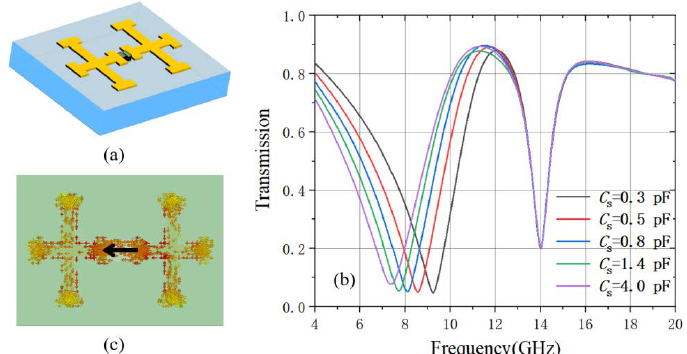
Figure 3. ( a ) the schematic of the double-cross and varactor diode unit cell and ( b ) its x-polarized transmission at different varactor diode capacitance and ( c ) its surface current of the transmission dip at 7.8 GHz when the diode capacitance is 1.4 pF.